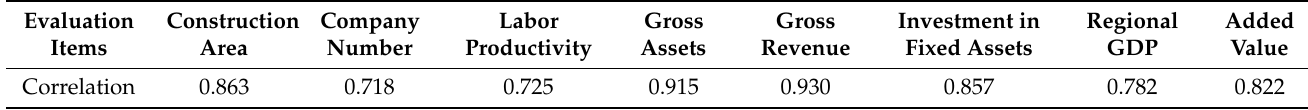
Table 2. Correlation of influencing factors.